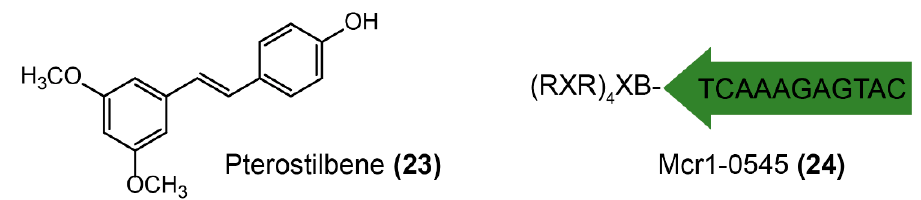
Figure 14. Inhibition of MCR-1 by molecules directly interacting with resistance enzymes or by targeting its mRNA.